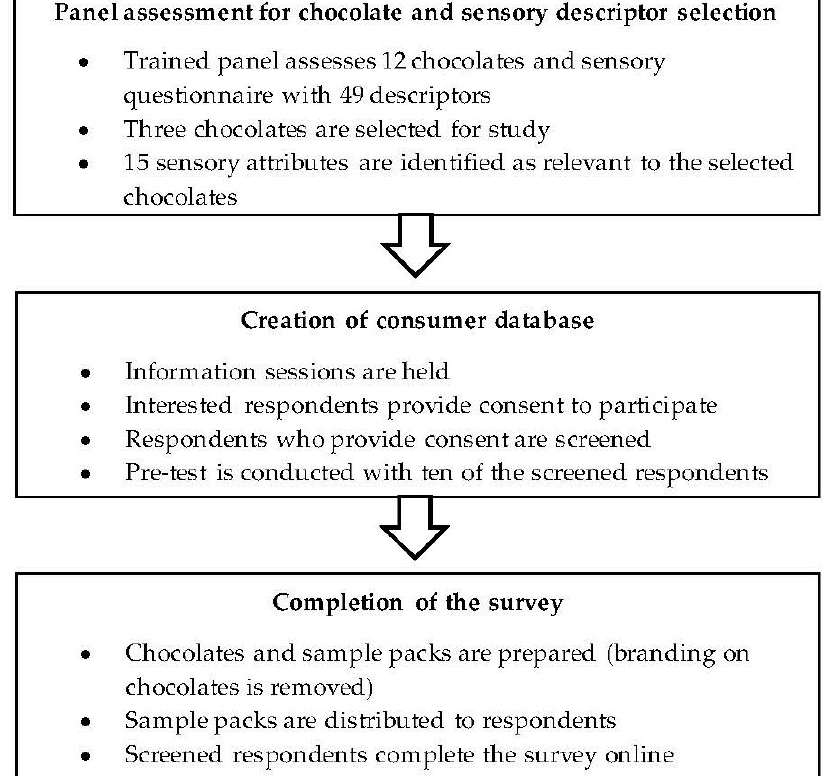
Figure 2. Main steps of the study.